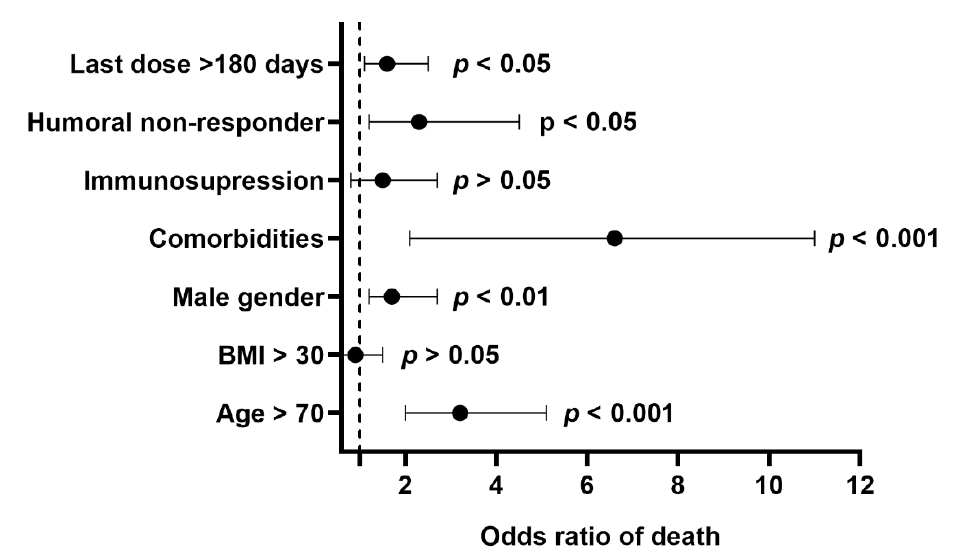
Figure 2. The odds (95% confidence interval) of death in vaccinated individuals requiring hospital- ization related to various patient characteristics ( n = 741). The last dose > 180 days parameter was assessed for fully vaccinated individuals ( n = 723). Table 4. The demographic, laboratory, and clinical characteristics of fully vaccinated patients ( n = 723) who presented their first COVID-19 symptoms less and more than 180 days after receiving the last